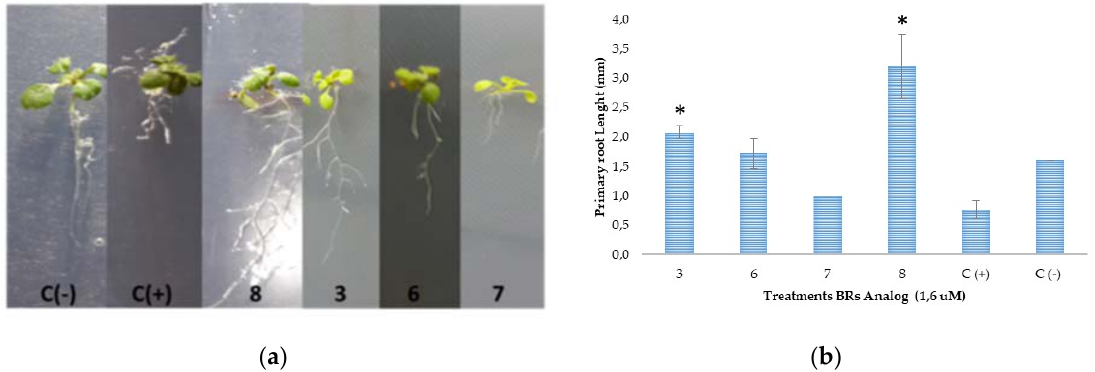
Figure 3. Influence of BR analogs ( 3 , 6 , 7 , 8 and BL (C+)) on the root elongation of A. thaliana . ( a ) Representative pictures of primary root growth of 15 ‐ day ‐ old wild ‐ type plants grown at 21 °C and incubated in growth chambers under conditions 16 h light/8 h dark, 90 μ E m − 2 s − 1 ; ( b ) Bar plot of primary root length (mean ± s.d., n = 15); (*) Indicate statistically significant differences between positive control (BL) and analogs treatments at the 0.05 significance level (Student’s t ‐ test).